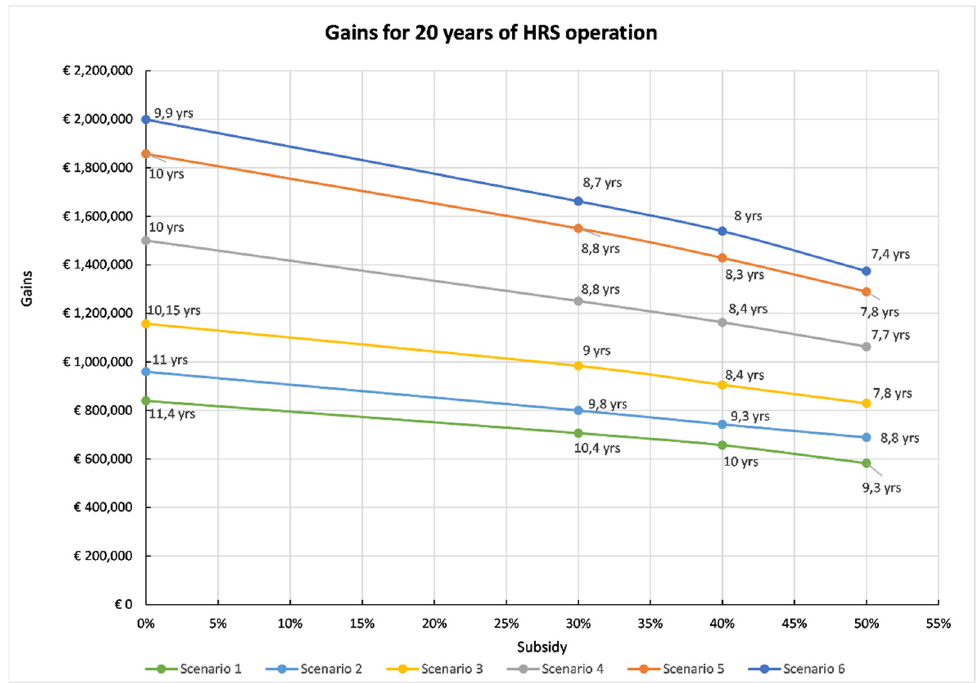
Figure 12. Effect of subsidy on payback period. Text on the bullets presents the payback period for each scenario and case examined.